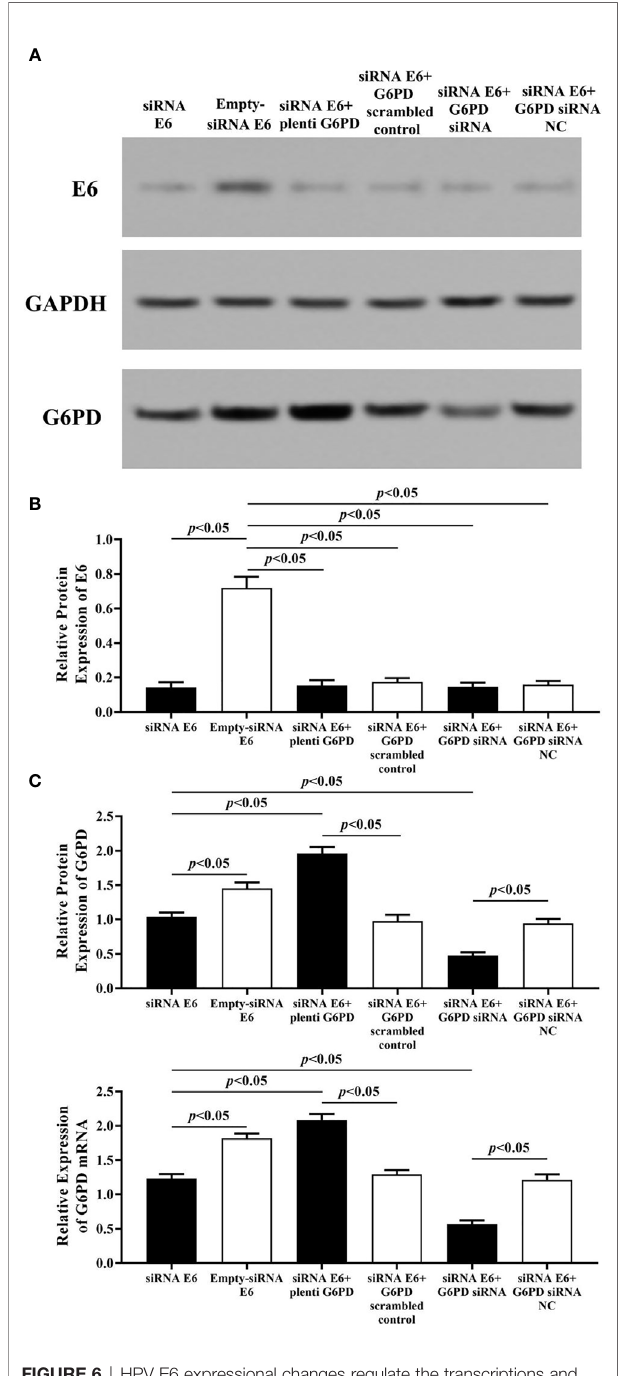
protein levels of G6PD in HeLa cells. The expression levels of E6 protein (A, B) and G6PD (A, C) /mRNA (C) were indicated by Western blots or RT- qPCR. (A) Representative blots from six groups. Statistical plots of the relative expression of E6 protein (B) , and G6PD protein/mRNA (C) . Data are presented as means ± SD (n =